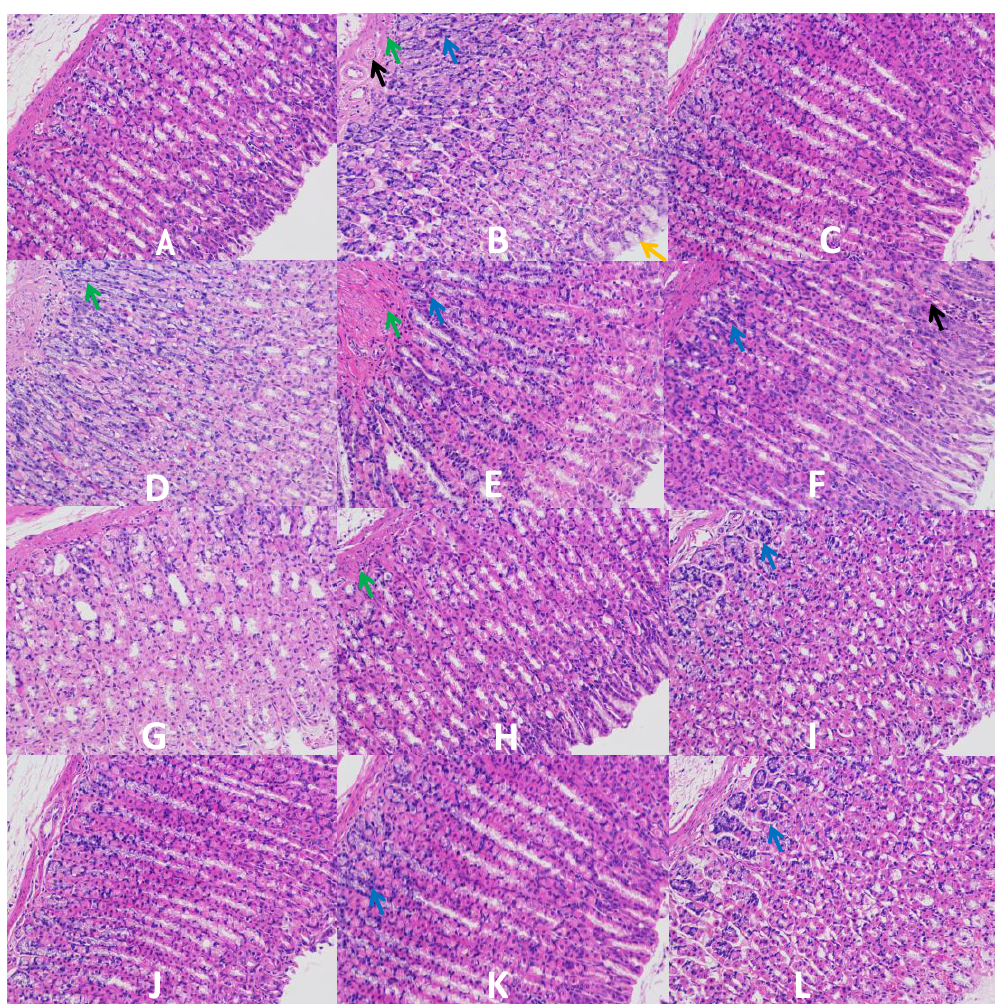
Figure 2. Histological observation of gastric mucosa treated by GLPs. ( A ): blank; ( B ): model; ( C ):